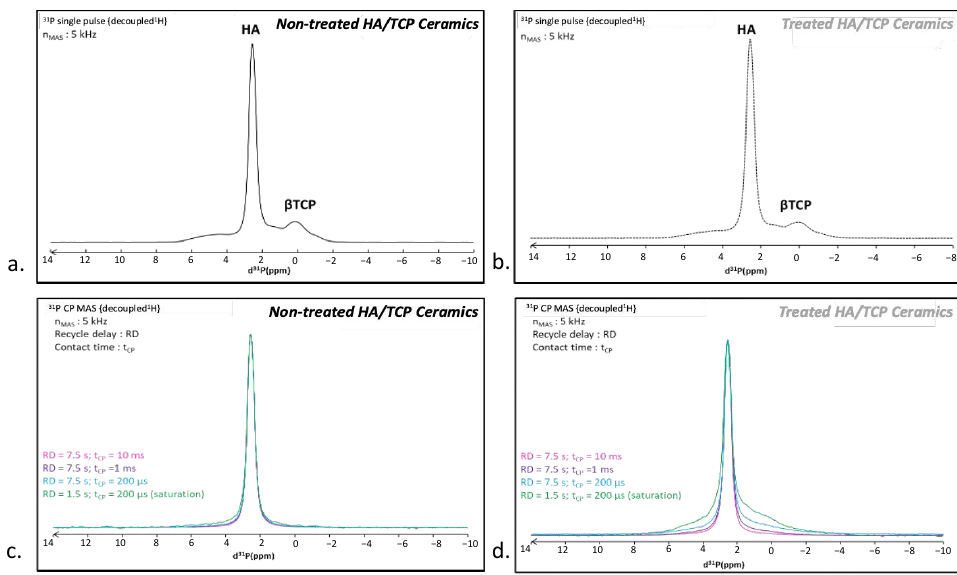
Figure 5. Single-pulse 31 P MAS NMR spectra of ( a ) untreated and ( b ) CO 2 -treated BCP scaffold. 1 H- 31 P CP MAS NMR spectra of ( c ) untreated and ( d ) CO 2 treated BCP scaffold at various conditions indicated on the figure. Arrow in ( d ) indicates the surface species induced by the CO 2